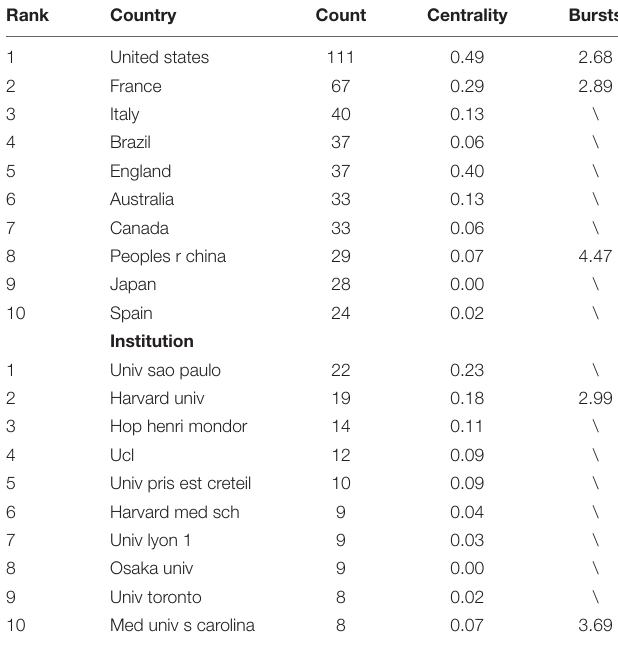
TABLE 5 | The top 10 countries or institution among 440